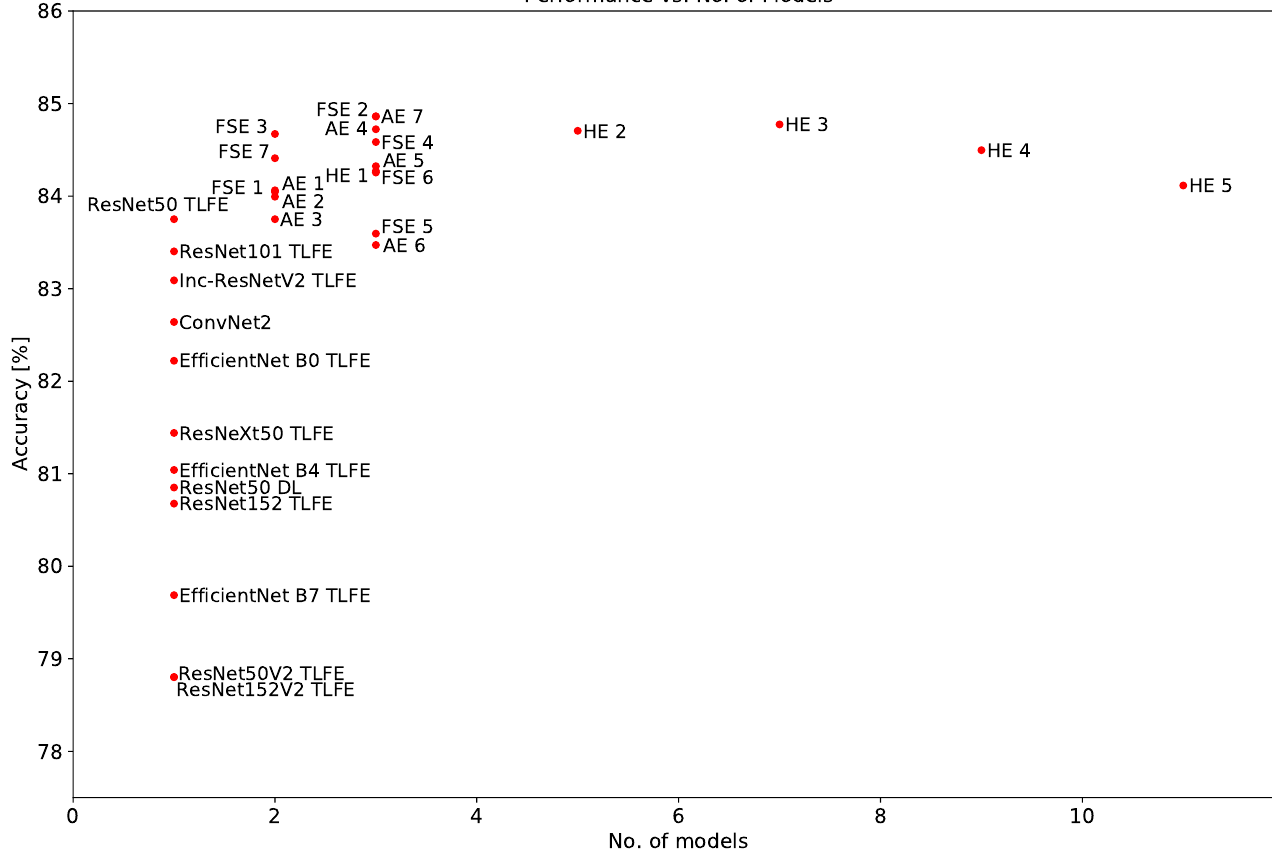
Figure 24. Model performance with reference to the number of models, zoomed in to show models with performances above 78%, FeatSpaceEnsNet, AvgEnsNet, and HybridEnsNet are abbreviated as FSE, AE, and HE, respectively.